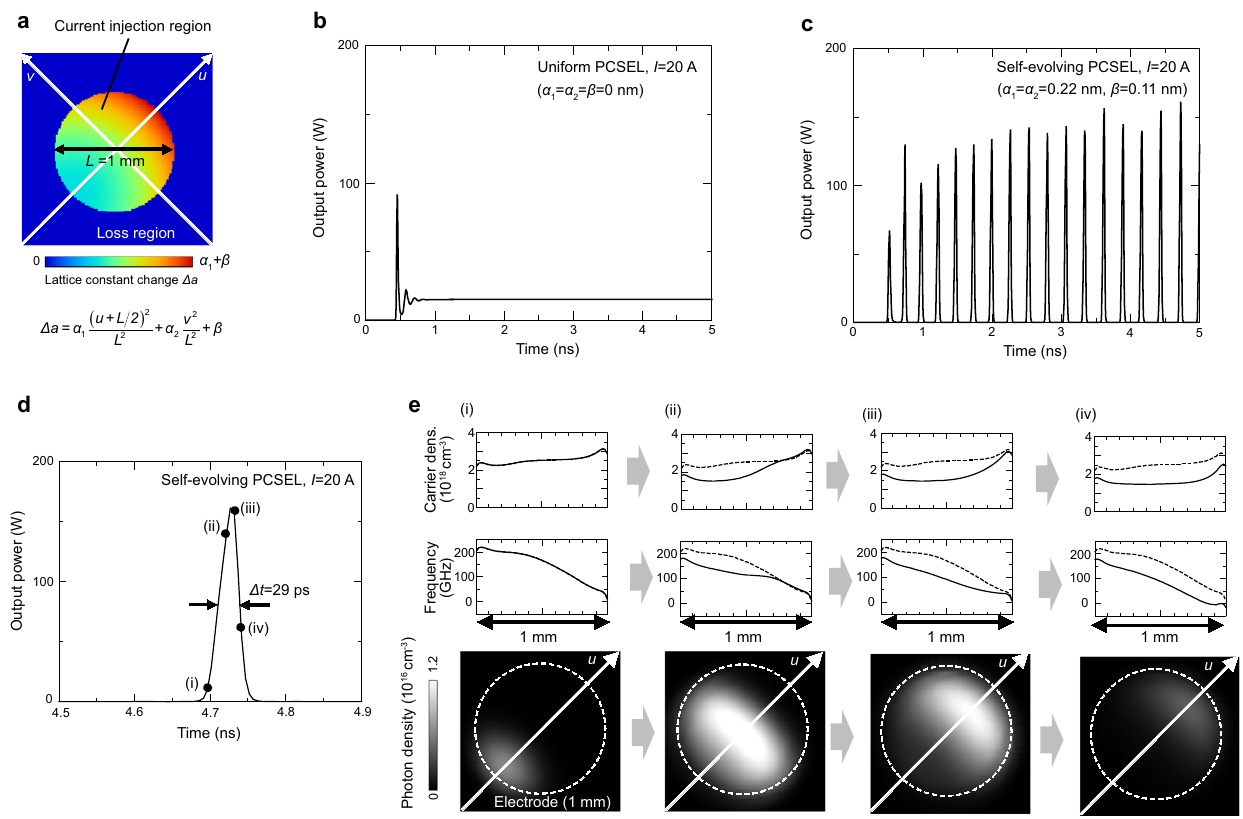
Fig. 2 | Simulated transient response of self-evolving photonic crystals. a Simulation model of a self-evolving photonic crystalwith 1-mm-diameter current injection. b , c Transientresponsewithoutandwithband-edgefrequencygradation. A constant injection current of 20A is used in the simulation. d Enlarged view of a